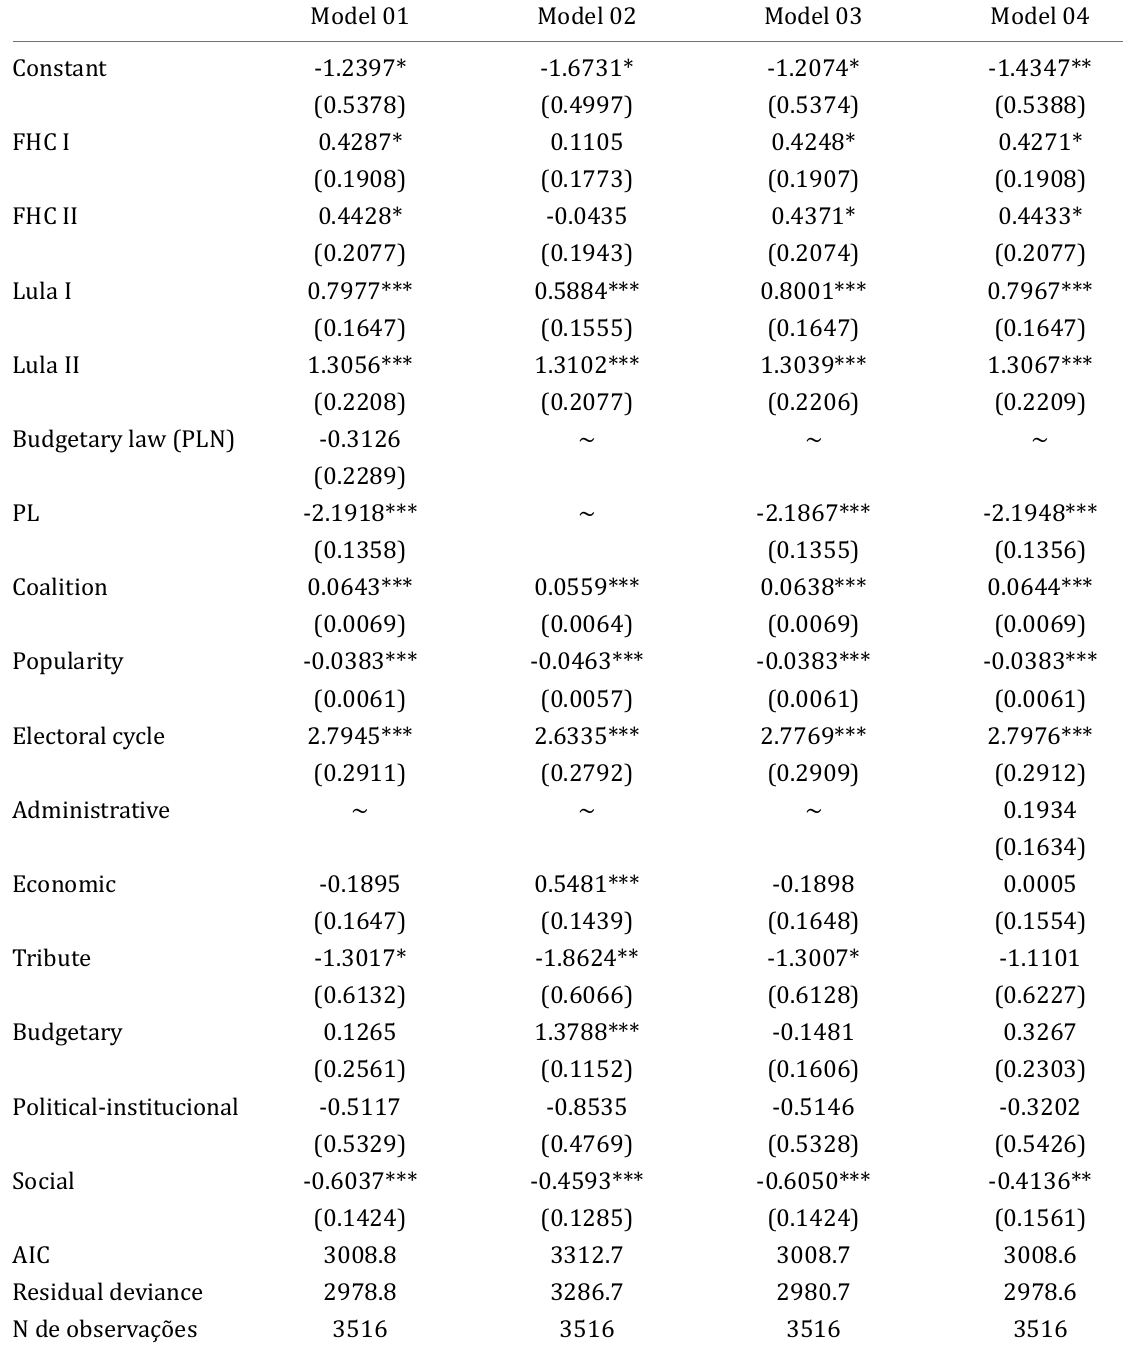
Table 3: Legislative success of the executive in Brazil: